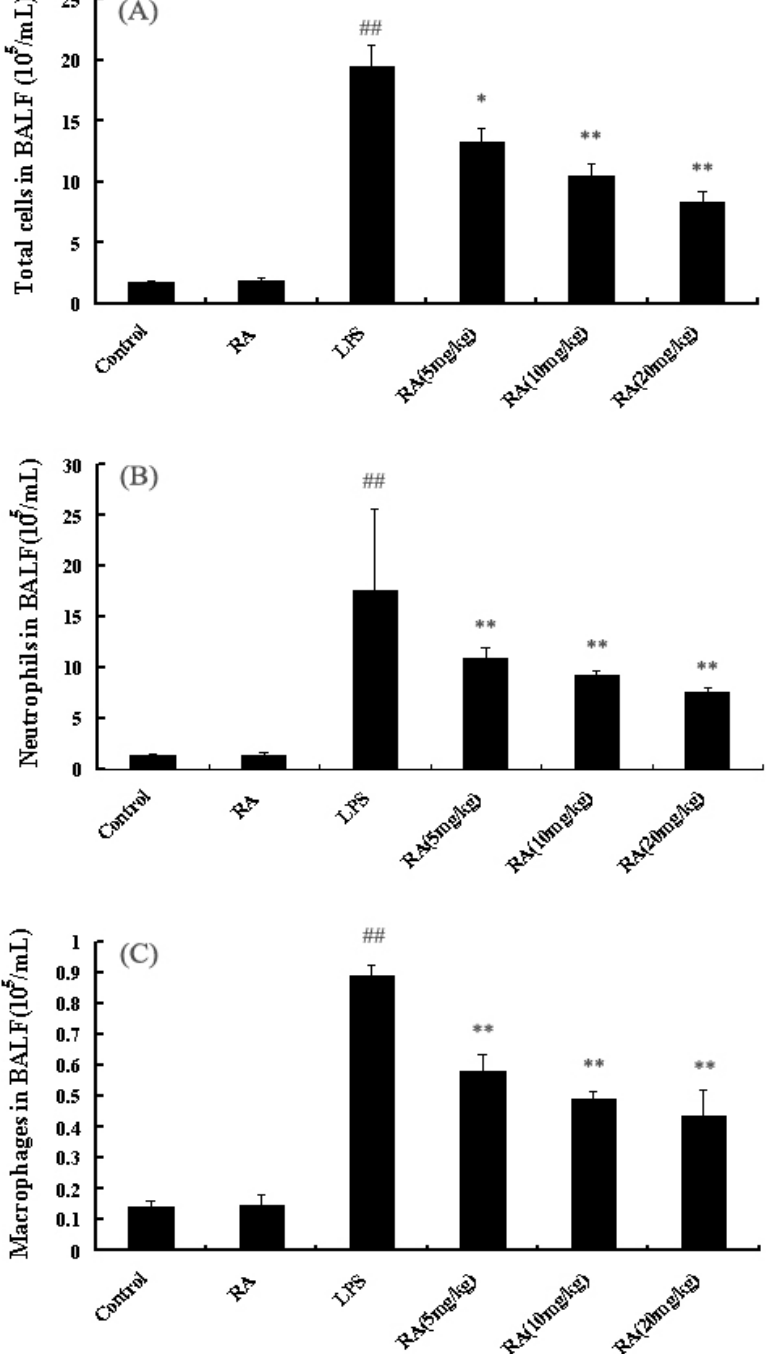
Figure 2. Effects of RA on the number of total cells, neutrophils, and macrophages in the BALF of LPS-induced ALI mice. Mice were given RA (5 mg/kg, 10 mg/kg, or 20 mg/kg) 1 h prior to an i.n. administration of LPS. BALF was collected at 24 h following